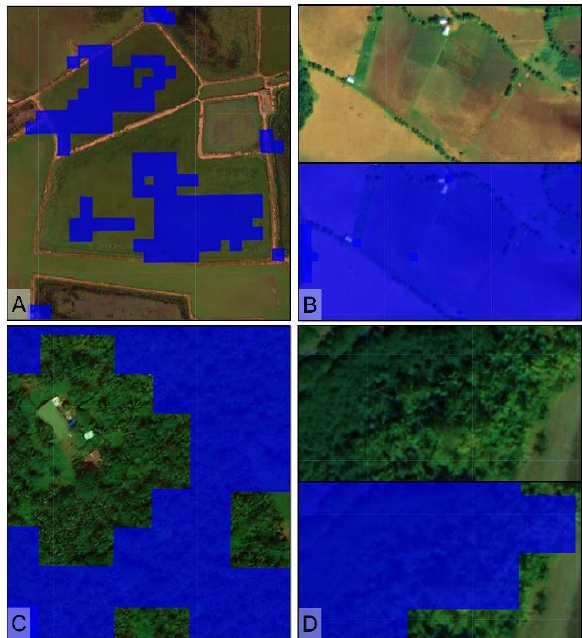
Figure 10 . Sites misclassified as mangroves: (A) aquaculture ponds, (B) croplands, (C) coconut trees, and (D) Nypa fruticans. The blue pixels are areas classified as mangroves in the MVI- based 2019 Mangrove Extent Map of the